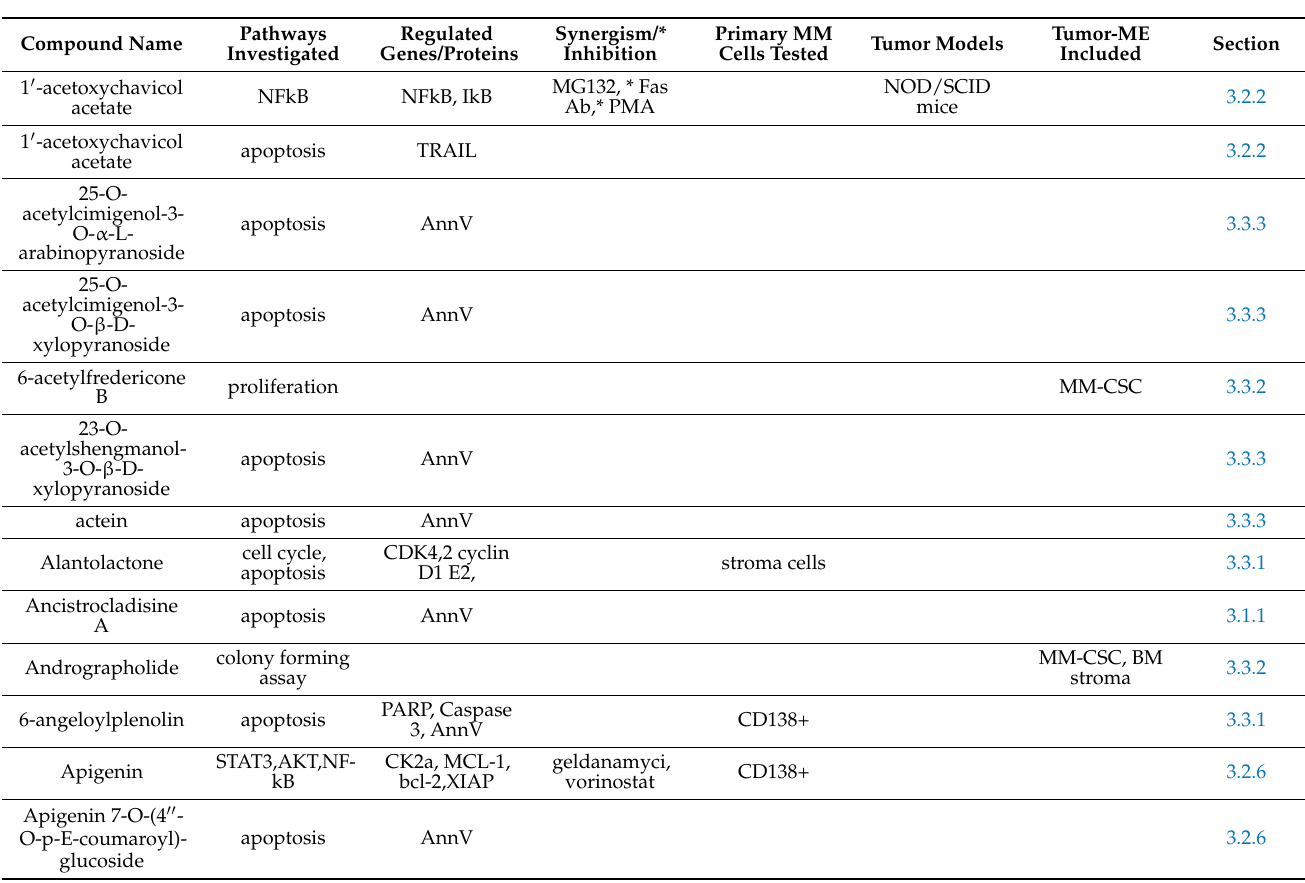
Table 2. Overview on investigated pathways and regulated molecules. Data collection is restricted to data presented in figures of the respective study dealing with investigations on myeloma cells only (MMP, mitochondrial membrane potential). Synergism and inhibition (marked with *) with other drugs are outlined (BTZ/bortezomib, Thal/thalidomide, Mel/melphalan, Dex/dexamethasone, Dox/doxorubicin, Cyclophos/cyclophosphamide, Pom/pomalidomide). Where applicable, the testing of the compounds on primary myeloma cells (CD138+ selected and patients’ bone marrow mononu- clear cells stained for analysis of myeloma cells with CD38 ++ /CD45 +/ − ) is noted. Some compounds were also tested in tumor models (mostly mice, with one exception using chorioallantoic membrane (CAM) assay). MM-cancer stem cells (MM-CSC) are rather part of the malignant cells; however, here they are outlined in the section of tumor-microenvironment (Tumor-ME) to underline the importance of these tumor-initiating cells. Data in this section also includes data obtained using stroma cells and osteoclasts (BM, bone